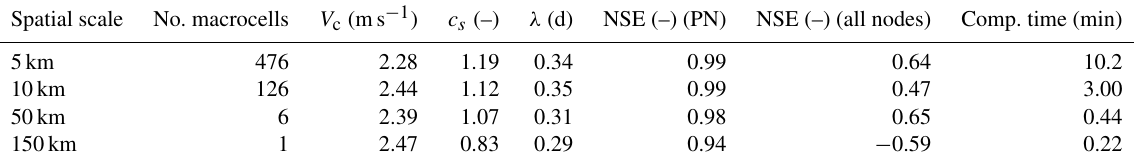
Table 2. Optimal model parameters, calibrated at Ponte Nuovo station (event February 1999), Nash–Sutcliffe efficiency indexes for Ponte Nuovo and all nodes, and computational time cost (for 100000 runs) resulting from the calibration procedure, for different spatial scale resolutions (size of the